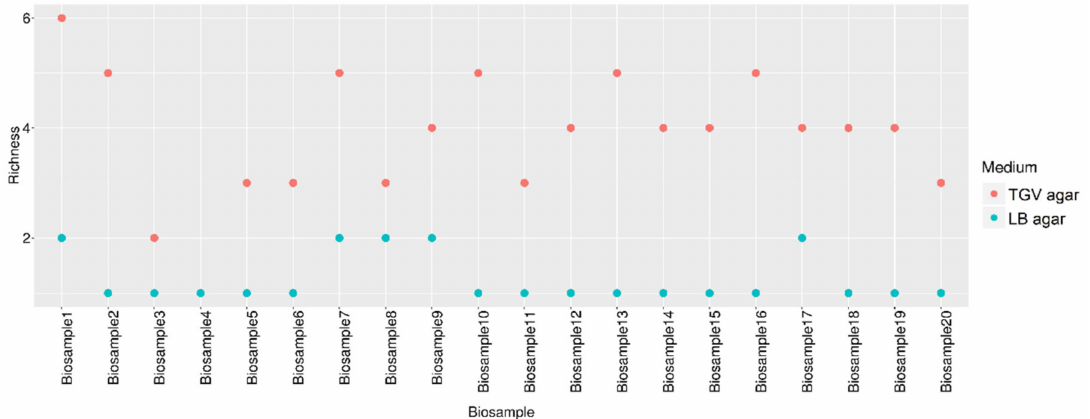
Figure 3. Comparison of the richness of bacteria that resulted in growth on TGV medium (after 4 h of culturing) compared with that of bacteria that showed growth (after 24 h) on LB agar (LB medium, Burkholderia cepacia -selective agar, chocolate agar, CHROMagar Staph aureus medium). Richness values for bio samples in two types of media are represented on a dot plot, displaying the distribution of numerical variables where each dot represents a value. The height of the column of dots represents the frequency for that value. The package ‘ggplot2’ within R (version 3.4.1) was